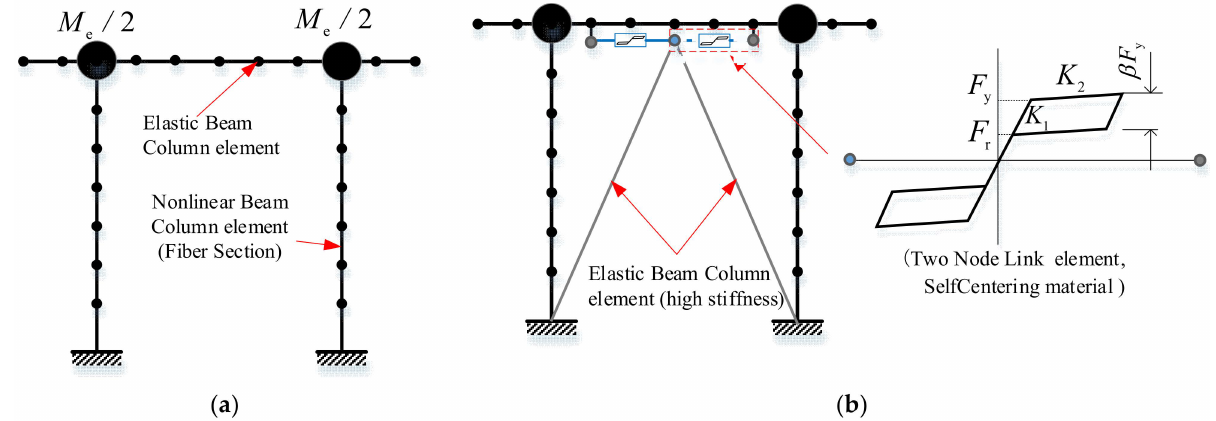
Figure 14. Finite models of bridge bent: ( a ) original bridge bent; ( b ) bridge bent with